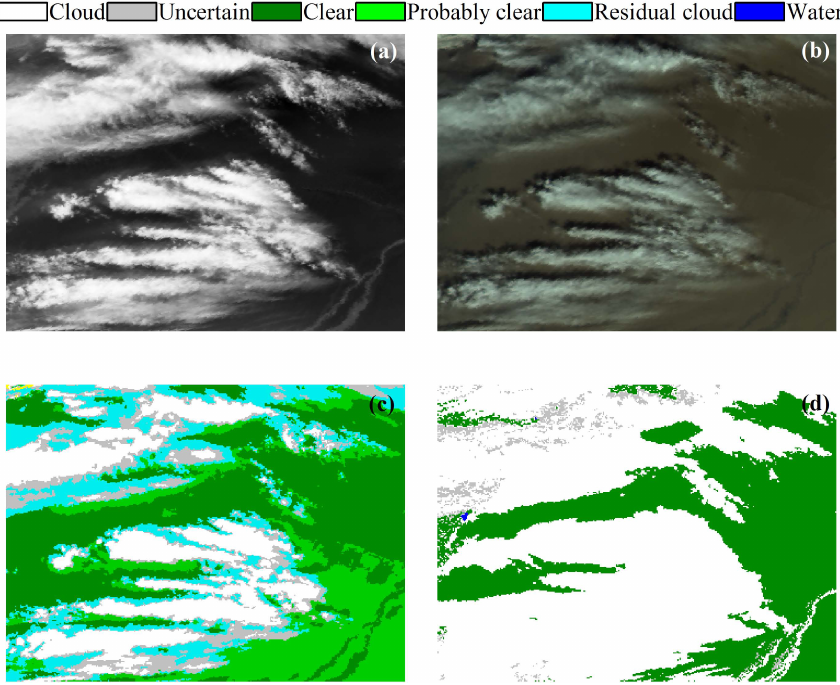
Fig. 6. The case over deserts on 6 March 2011, at 05:25:00UTC. (a) The gray-scale image of VIRR channel 4 (10.3–11.3µm); (b) the true-color VIRR image composed of channel 1 (red), channel 9 (green), and channel 7 (blue); (c) the cloud mask result from the algorithm proposed in this study; (d) the official cloud mask product image from VIRR.